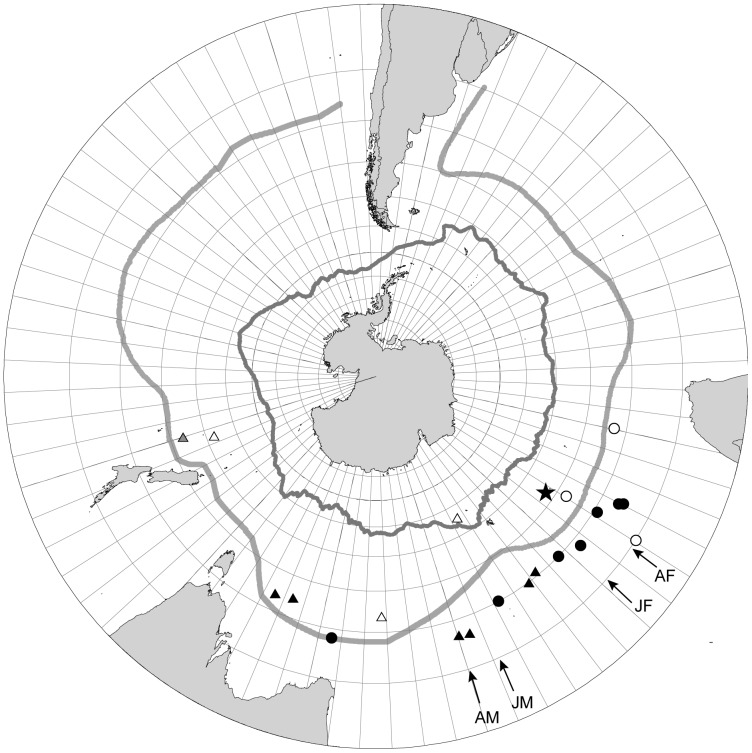
Locations of the centre of preferred ocean foraging zones for individual wandering albatrosses.Positions refer to different age and sex classes tracked by satellite telemetry during the migration from the breeding sites at Crozet Islands. Filled circles: juvenile females, open circles: adult females, filled triangles: juvenile males, open triangles: adult males. The grey triangle refers to an adult of unknown sex. Mean longitudes for each age category (JF: juvenile females, AF: adult females, JM: juvenile males, AM: adult males) are indicated by arrows. The starting point located at the Crozet Island is indicated by a star and the Sub-Tropical and Sub-Antarctic Fronts located around the Antarctic continent are indicated by light grey and dark grey lines, respectively.